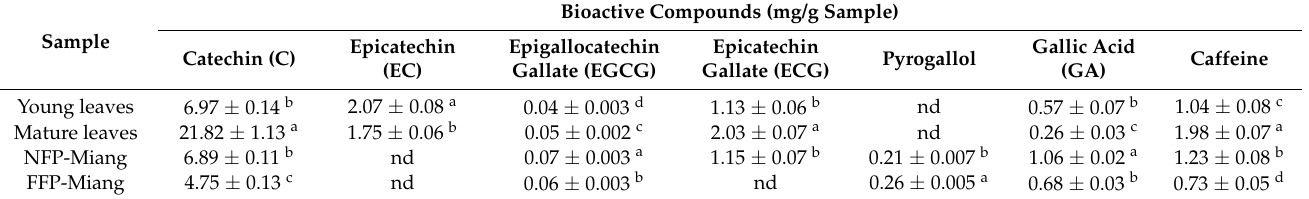
Table 1. The contents of catechin-related compounds and some bioactive compounds in Miang samples: Young tea leaves, mature tea leaves, non-filamentous fungi-process-based fermented tea leaves (NFP-Miang), and filamentous fungi-process- based fermented tea leaves